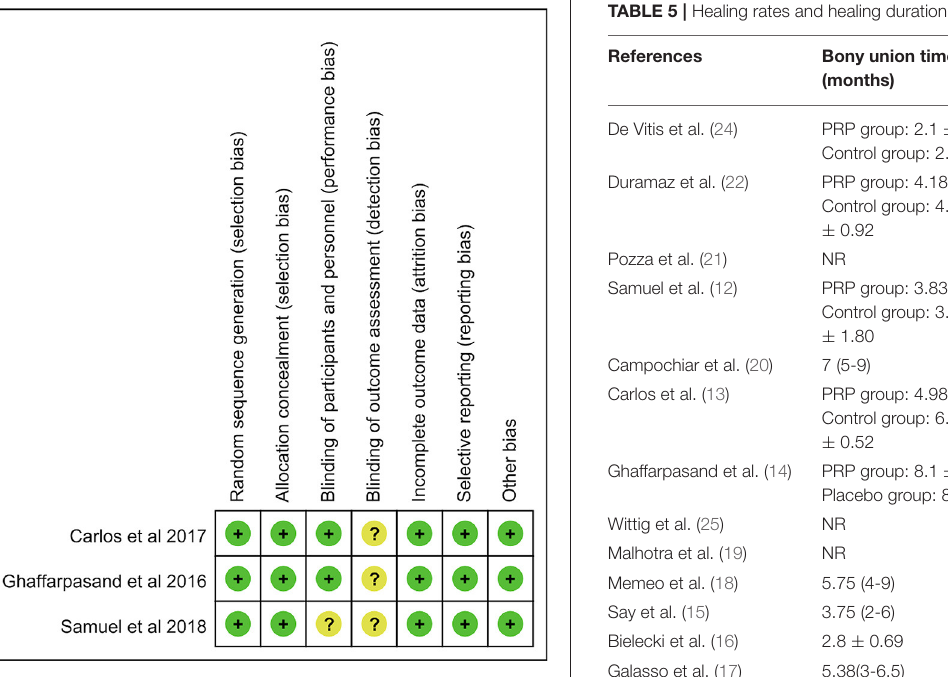
FIGURE 2 | The risk of bias of all prospective clinical studies.